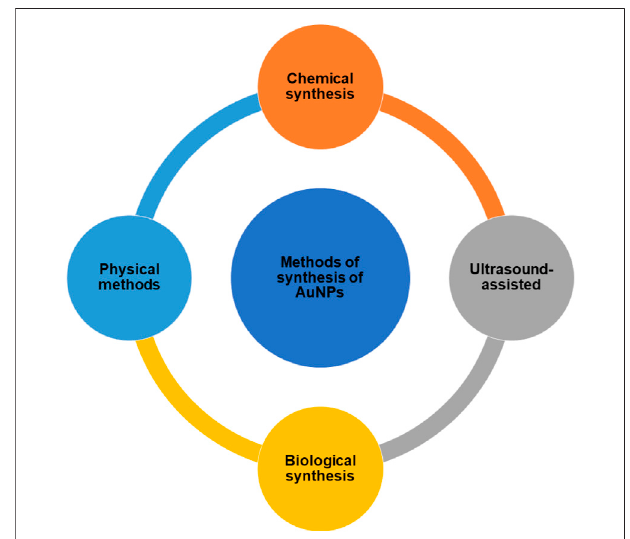
FIGURE 1 | Methods for the synthesis of